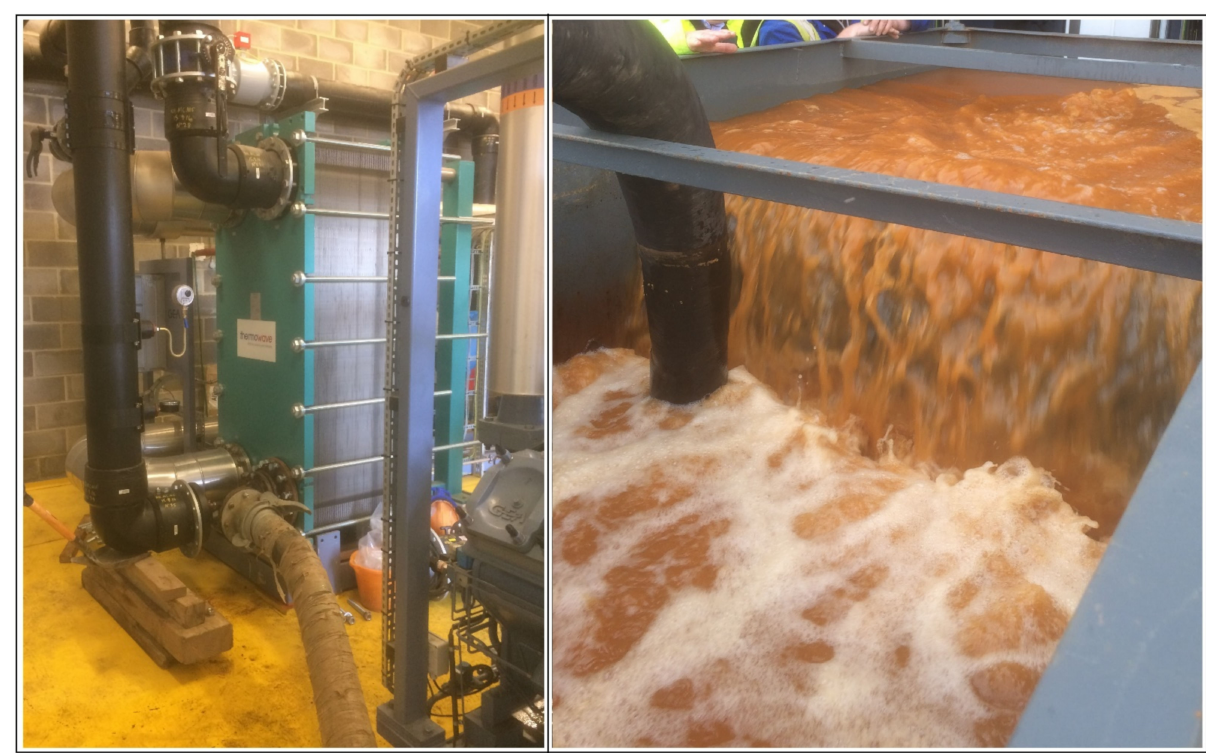
Figure 4. Periodic recirculation of citric acid solution through the plate heat exchanger at Abbotsford Road, Gateshead, UK ( left ), to remove accumulated ochre (which can be seen in the recirculation tank, ( right ). Reprinted with permission from ref. [70]. Copyright 2019 David